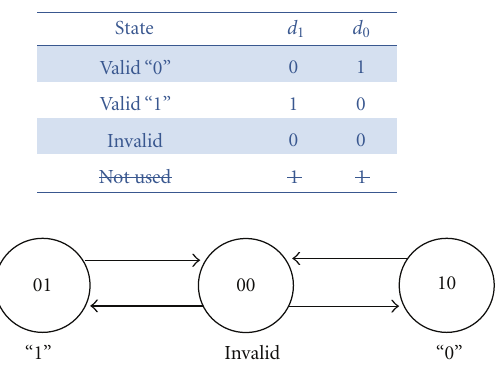
Figure 9: Three-state